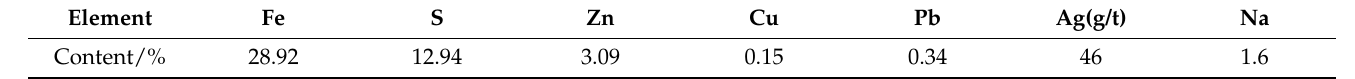
Table 2. Main relevant elements’ content in residue samples (%).